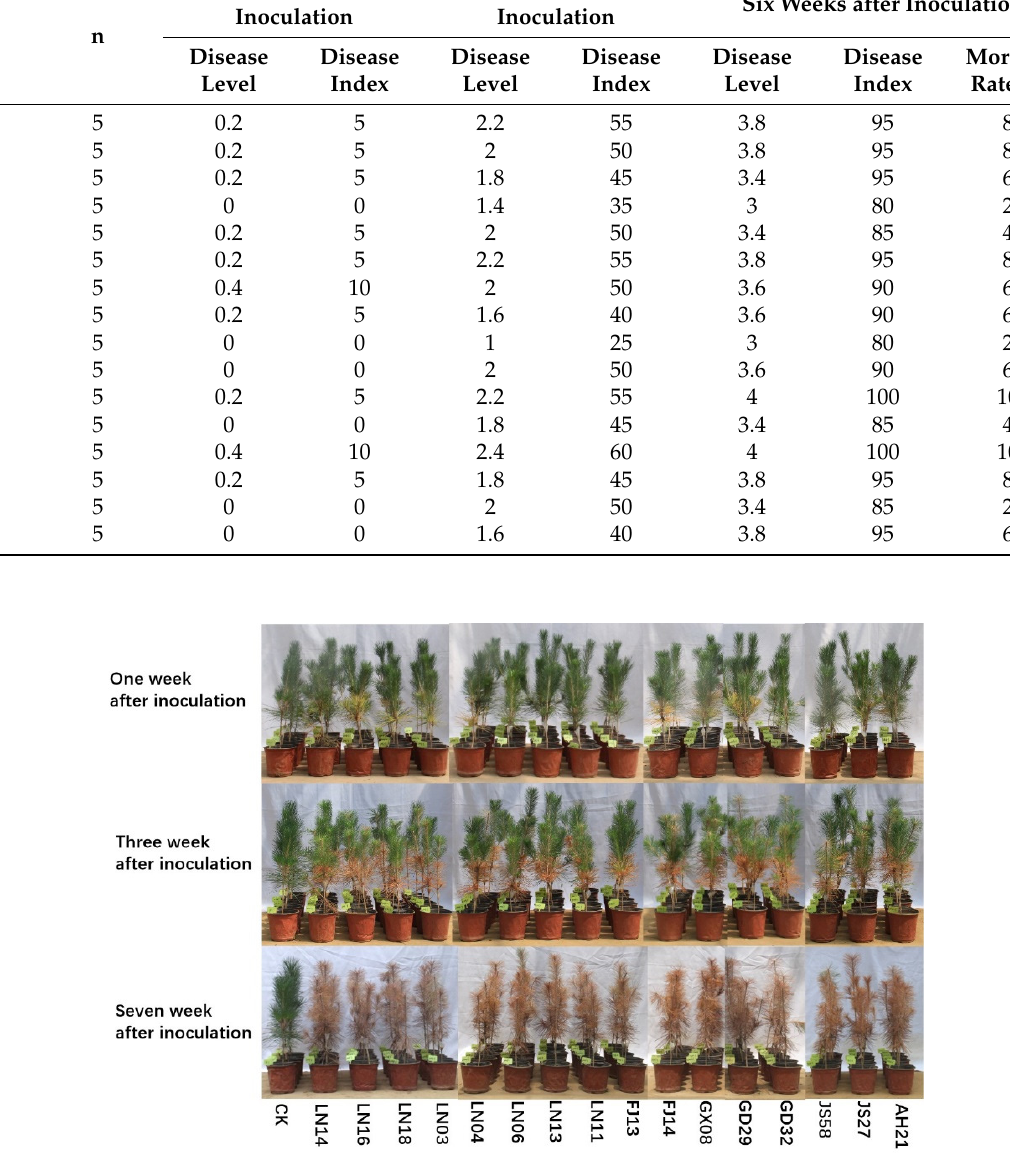
Figure 3. Symptoms of P. thunbergii after artificial inoculation with 16 strains of PWN.